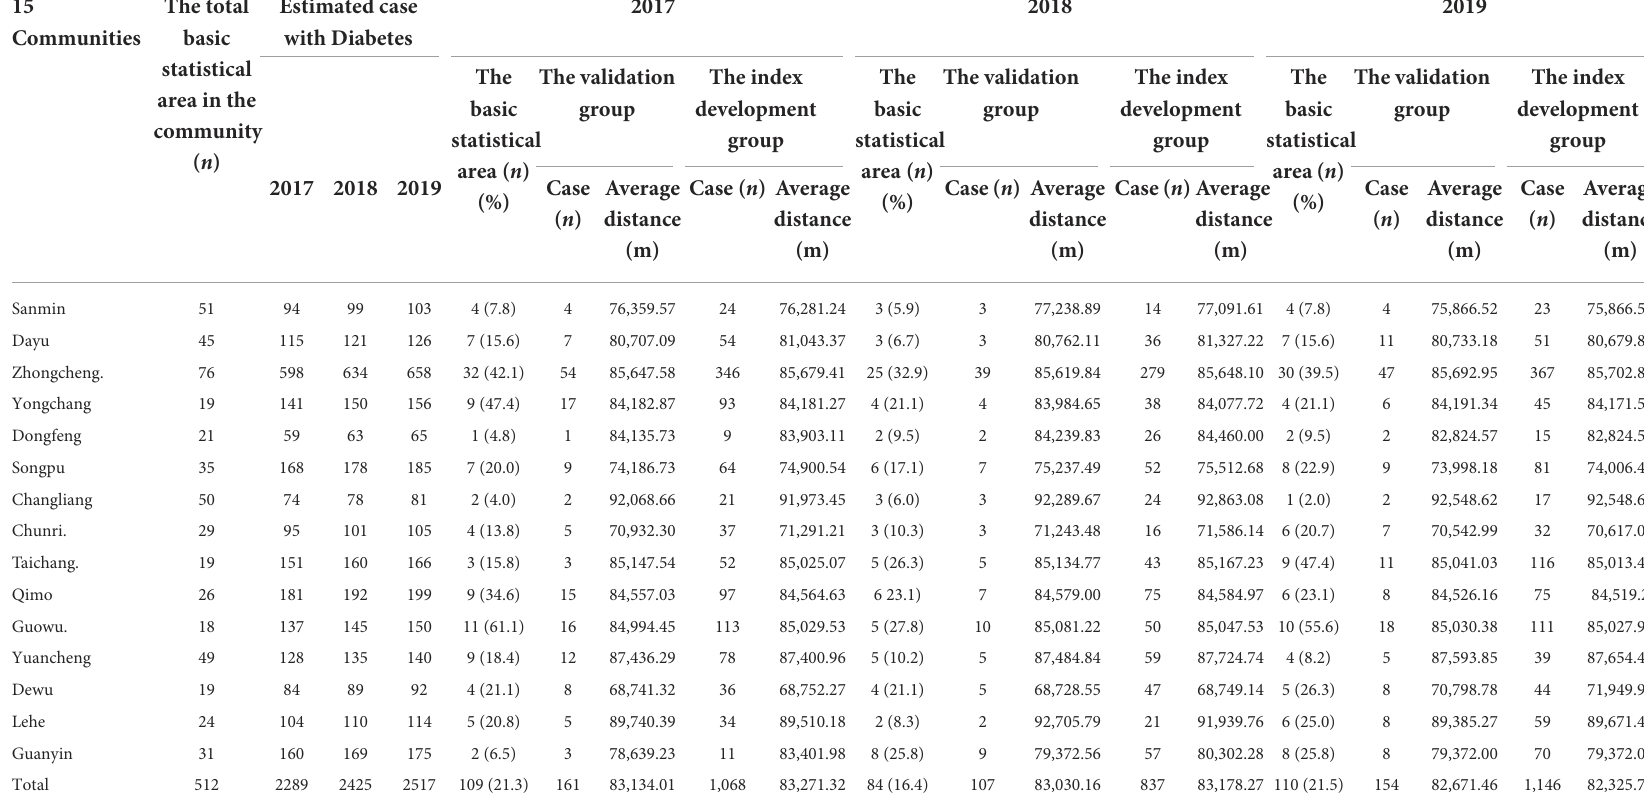
TABLE 4 The actual and estimated distances between living in 15 communities of Yuli and medical center among patients with